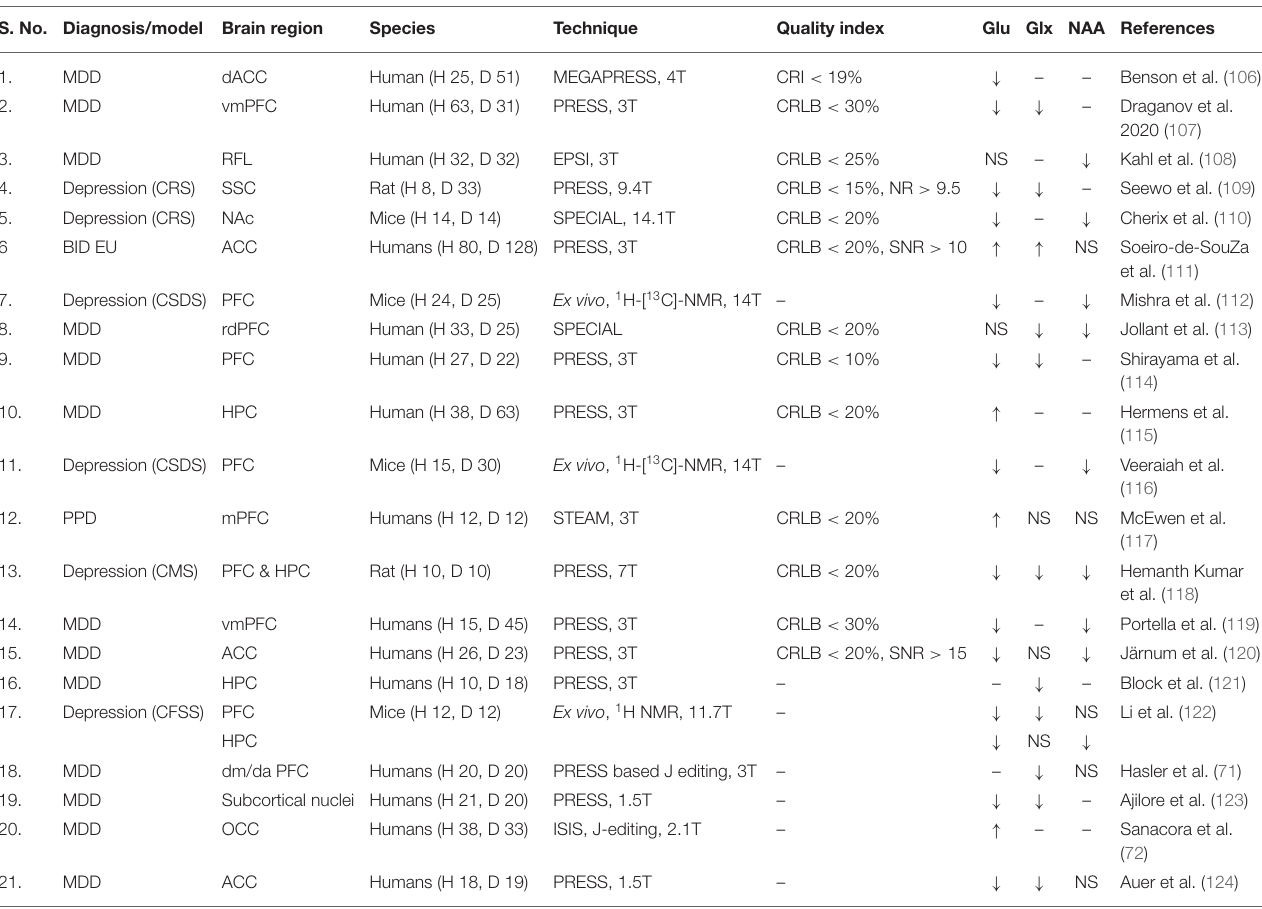
TABLE 1 | Brain glutamate homeostasis in